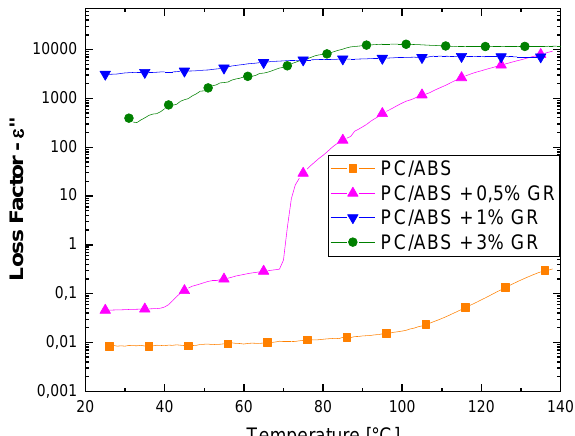
Figure 6. Effect of temperature on loss factor of samples obtained by solvent dispersion of GR and evaporation solvent removal method.